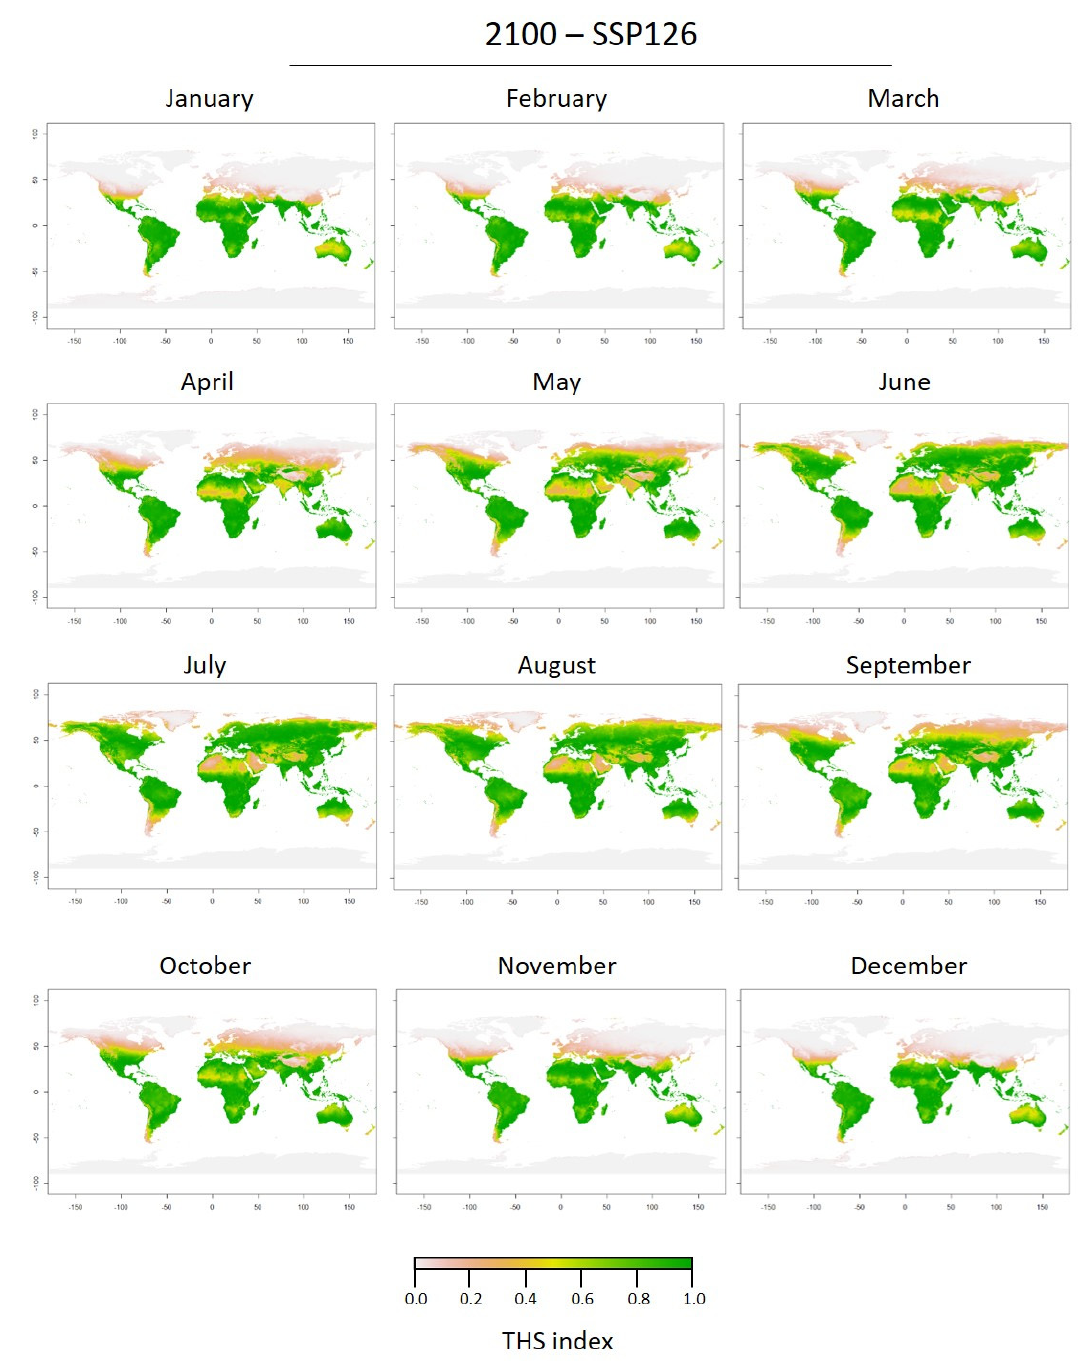
Figure 7. 2100-SSP126 monthly predictions of Thermal Habitat Suitability (THS) of the medusa stage of Craspedacusta sowerbii based on the Thermal Performance Curve (TPC) performed on the activity rate (pulsations min − 1 , lower panel).